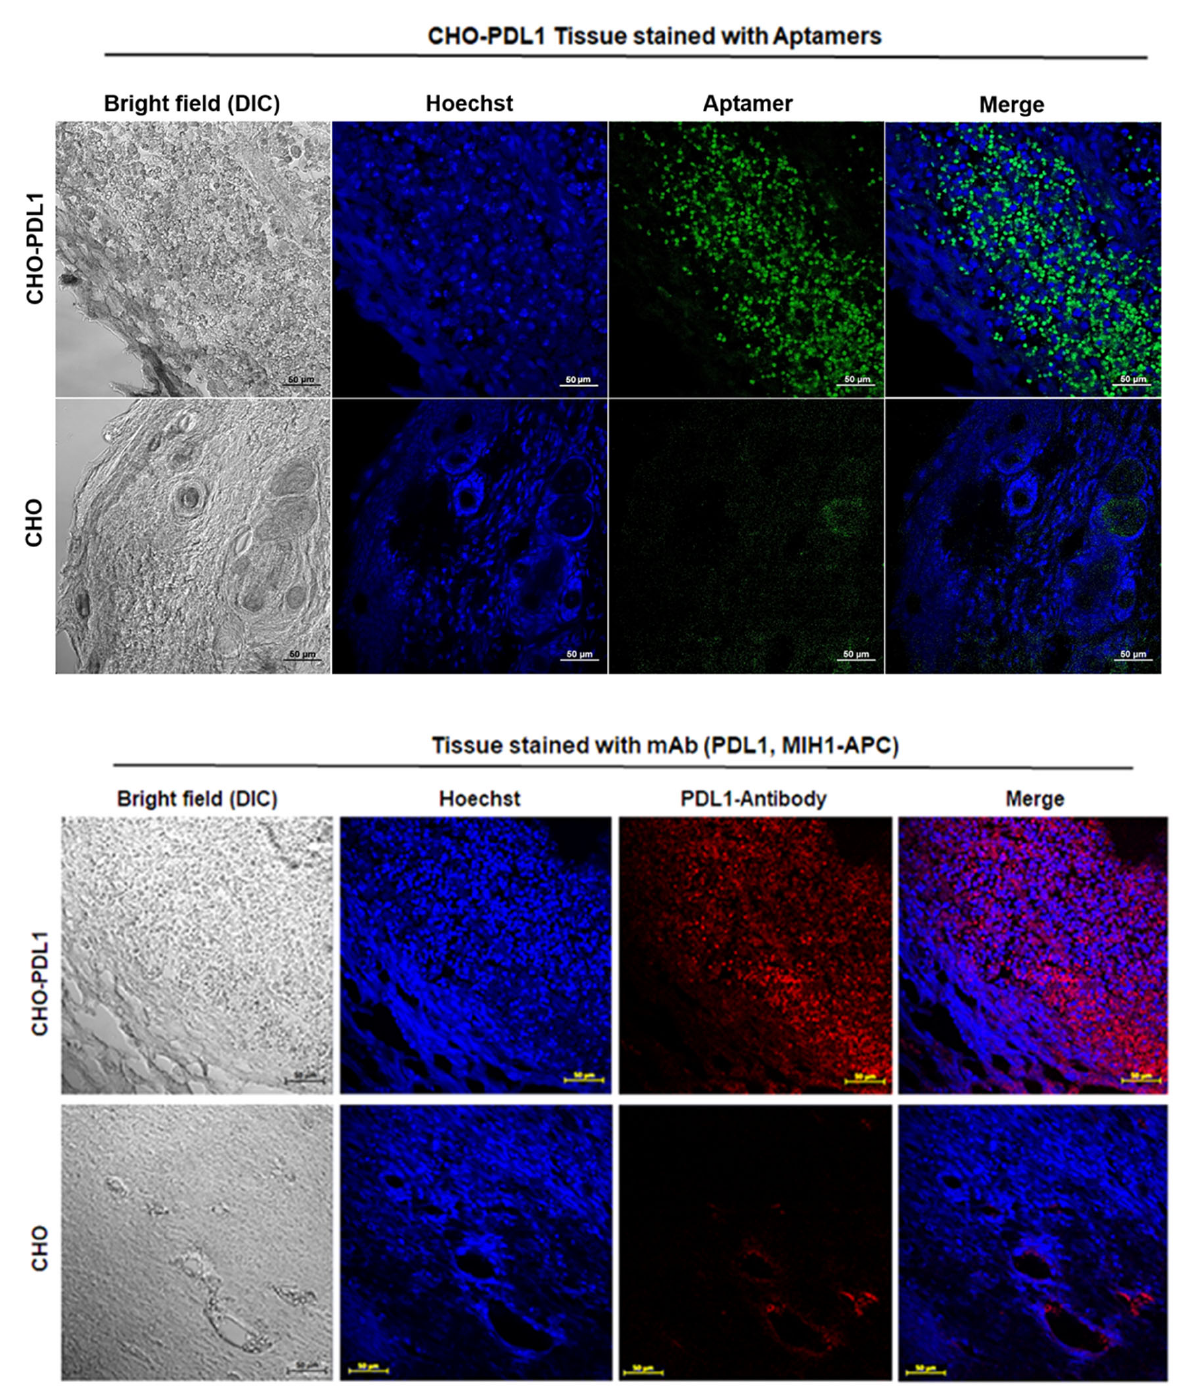
Figure 7. Ex vivo detection of PD-L1 expression in tumor tissue. Tumors formed in mice inoculated with aAPC/CHO-K1 and PD-L1 aAPC/CHO-K1 cells were excised, labeled with 2c2s-FAM ( top panel) or control PD-L1 antibody (MIH1, bottom panel) and imaged by confocal fluorescence mi ‐ croscopy.